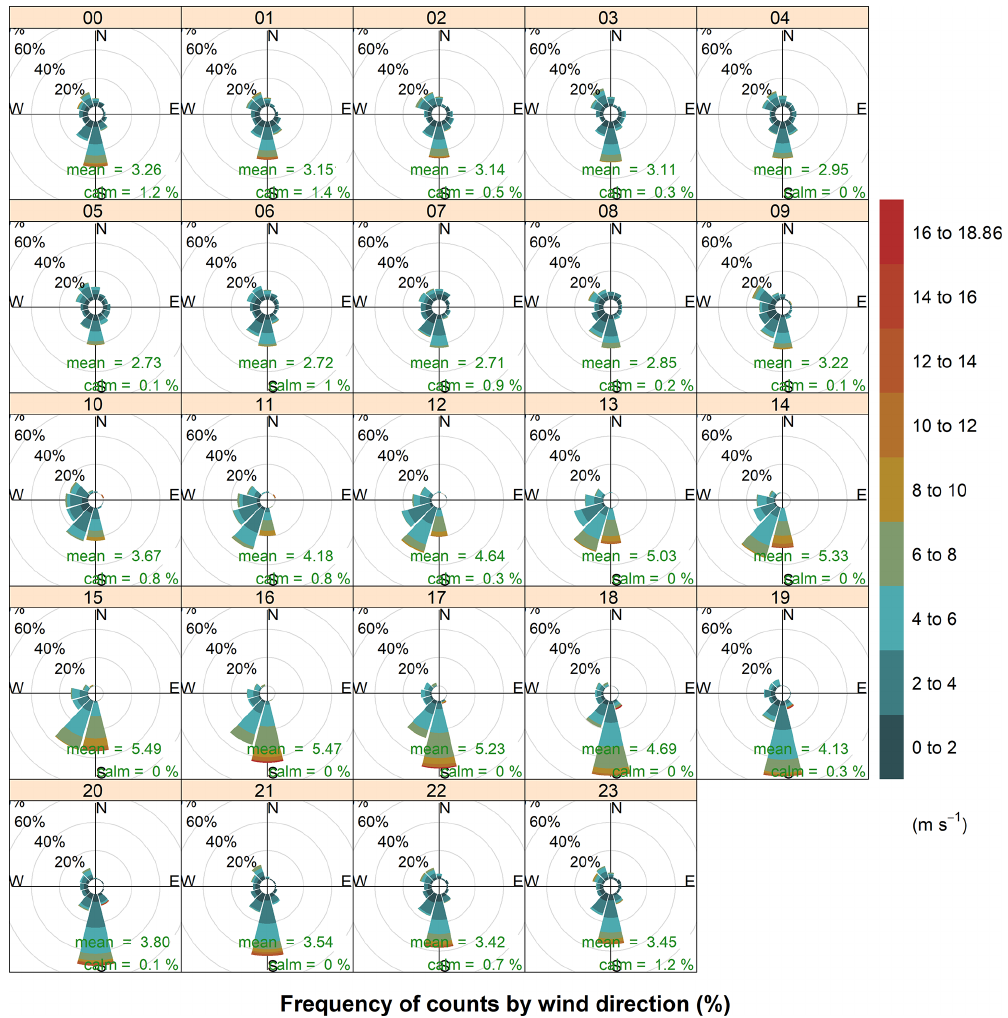
Figure 4. Hourly wind roses during the aerosol sampling at HBAO. The arithmetic means and percentage of calm conditions, when wind speeds are below detection, are reported in green. Time is in UTC. For 7–14 July 2017 no surface wind data are